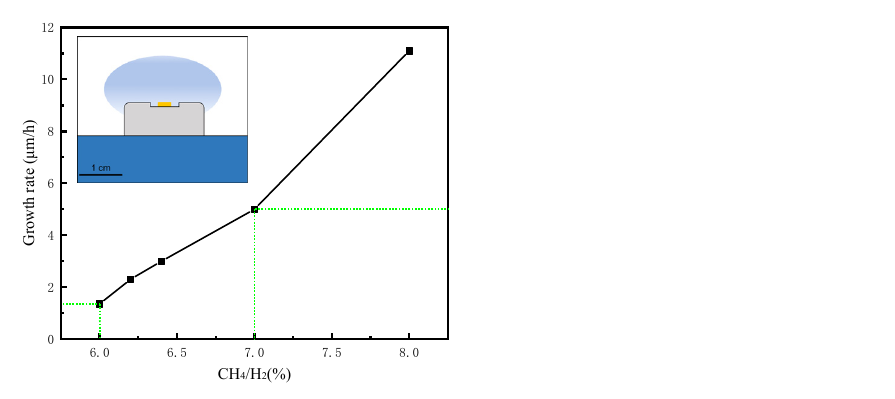
Figure 1. The growth rate of diamond versus CH 4 /H 2 ratio (Samples’ position (yellow) is shown in the inset).